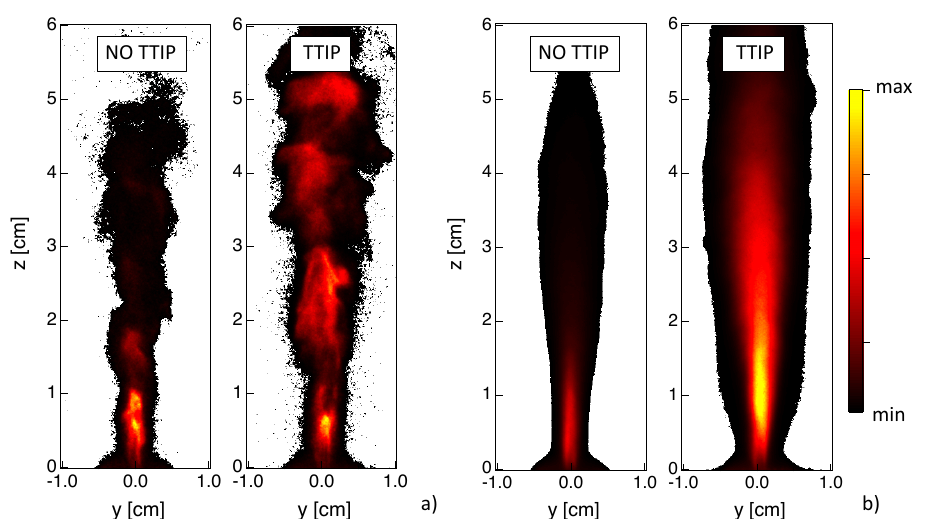
Figure 5. ( a ) Instantaneous and ( b ) time-averaged images of line-of-sight-integrated global emission for the reactive cases (left) without and (right) with injection of TTIP.